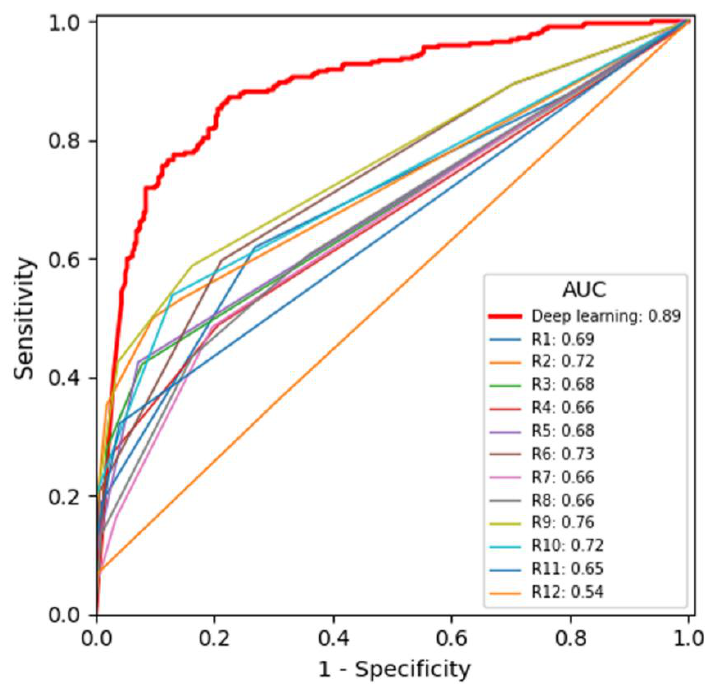
Figure 4. Receiver operating characteristic curves of the deep learning algorithm and the 12 radiol- ogists. Radiologists R7–R12 are residents, whereas R1–R6 are attending radiologists. AUC = area under the curve. Table 3. Secondary analysis by object